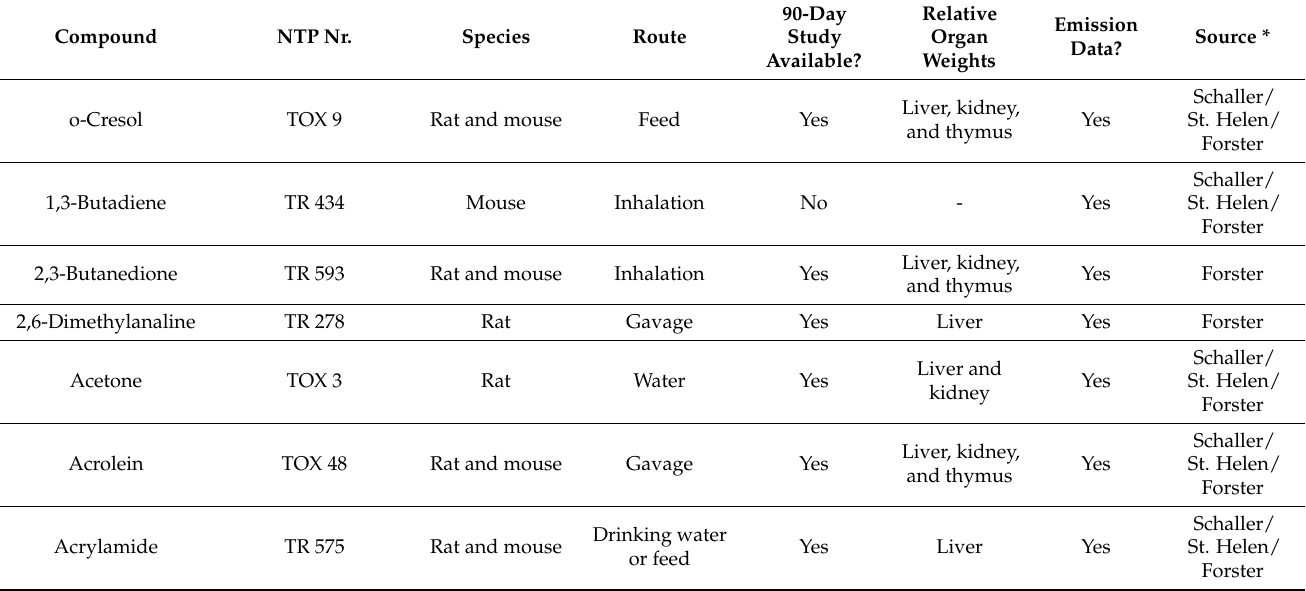
Table A1. Available toxicity and emission